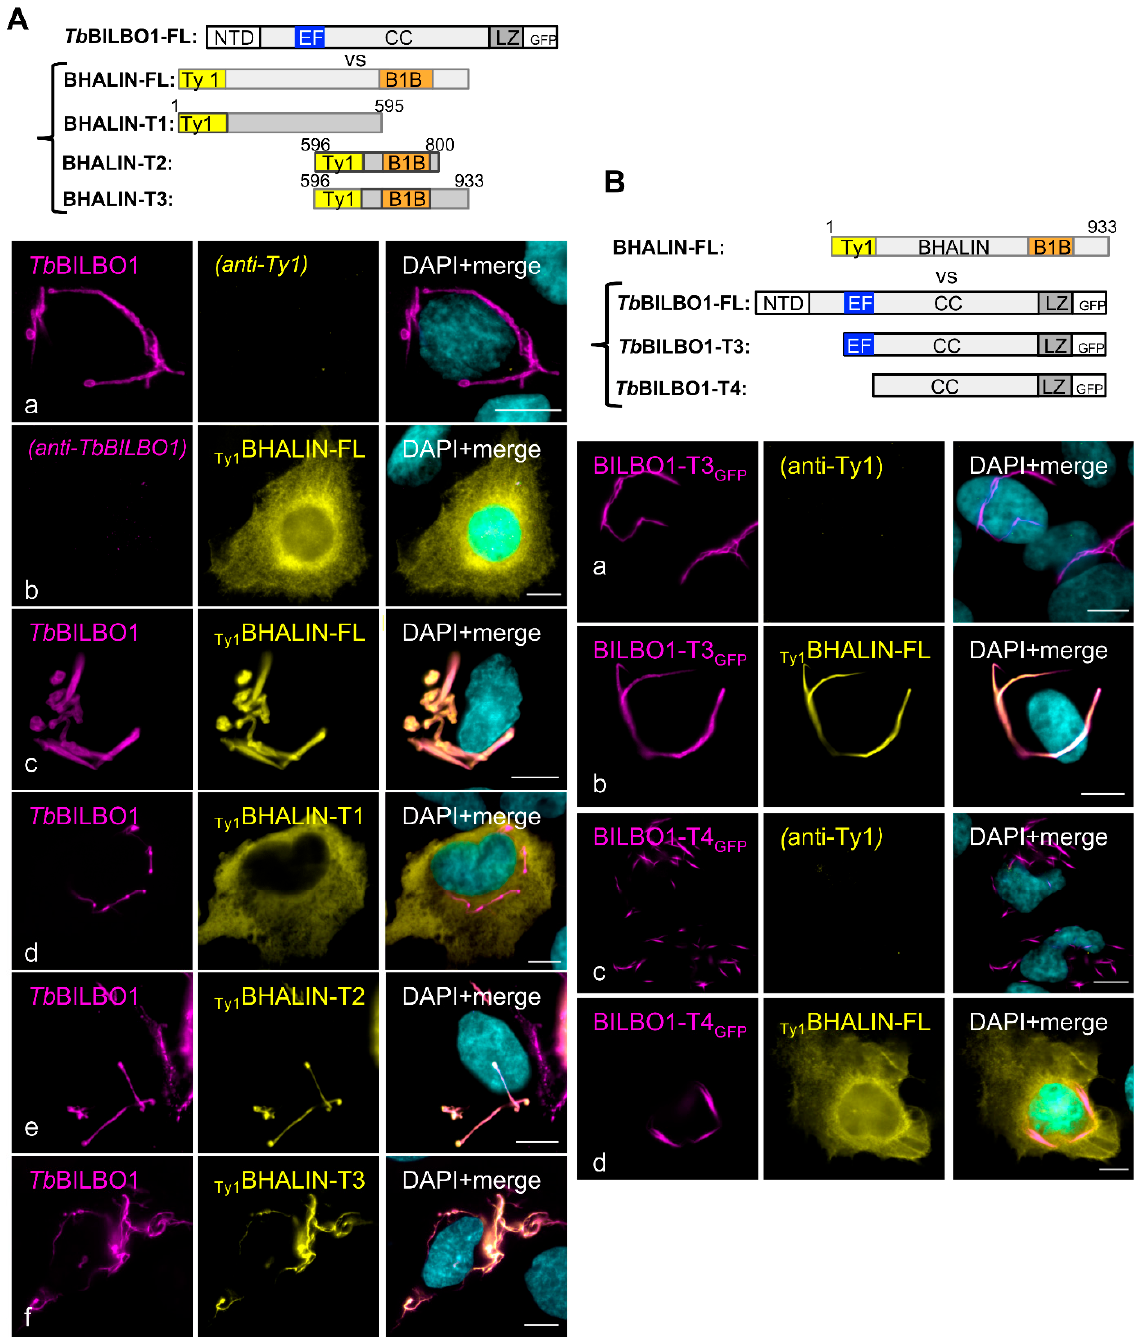
Figure 3. BHALIN interacts with Tb BILBO1 when expressed in U-2 OS cells and requires the EF-hand motifs. ( A ) Expression of full-length Tb BILBO1 ( a ), of Ty1 BHALIN-FL ( b ), and co-expression of Tb BILBO1 and Ty1 BHALIN-FL ( c ), Ty1 BHALIN-T1 ( d ), Ty1 BHALIN-T2 ( e ) and Ty1 BHALIN-T3 ( f ); interaction was observed for BHALIN-FL, T2 and T3. ( B ) Expression of truncations of Tb BILBO1-T3 GFP and Tb BILBO1-T4 GFP without or with Ty1 BHALIN-FL. Scale bars = 10 μ m.